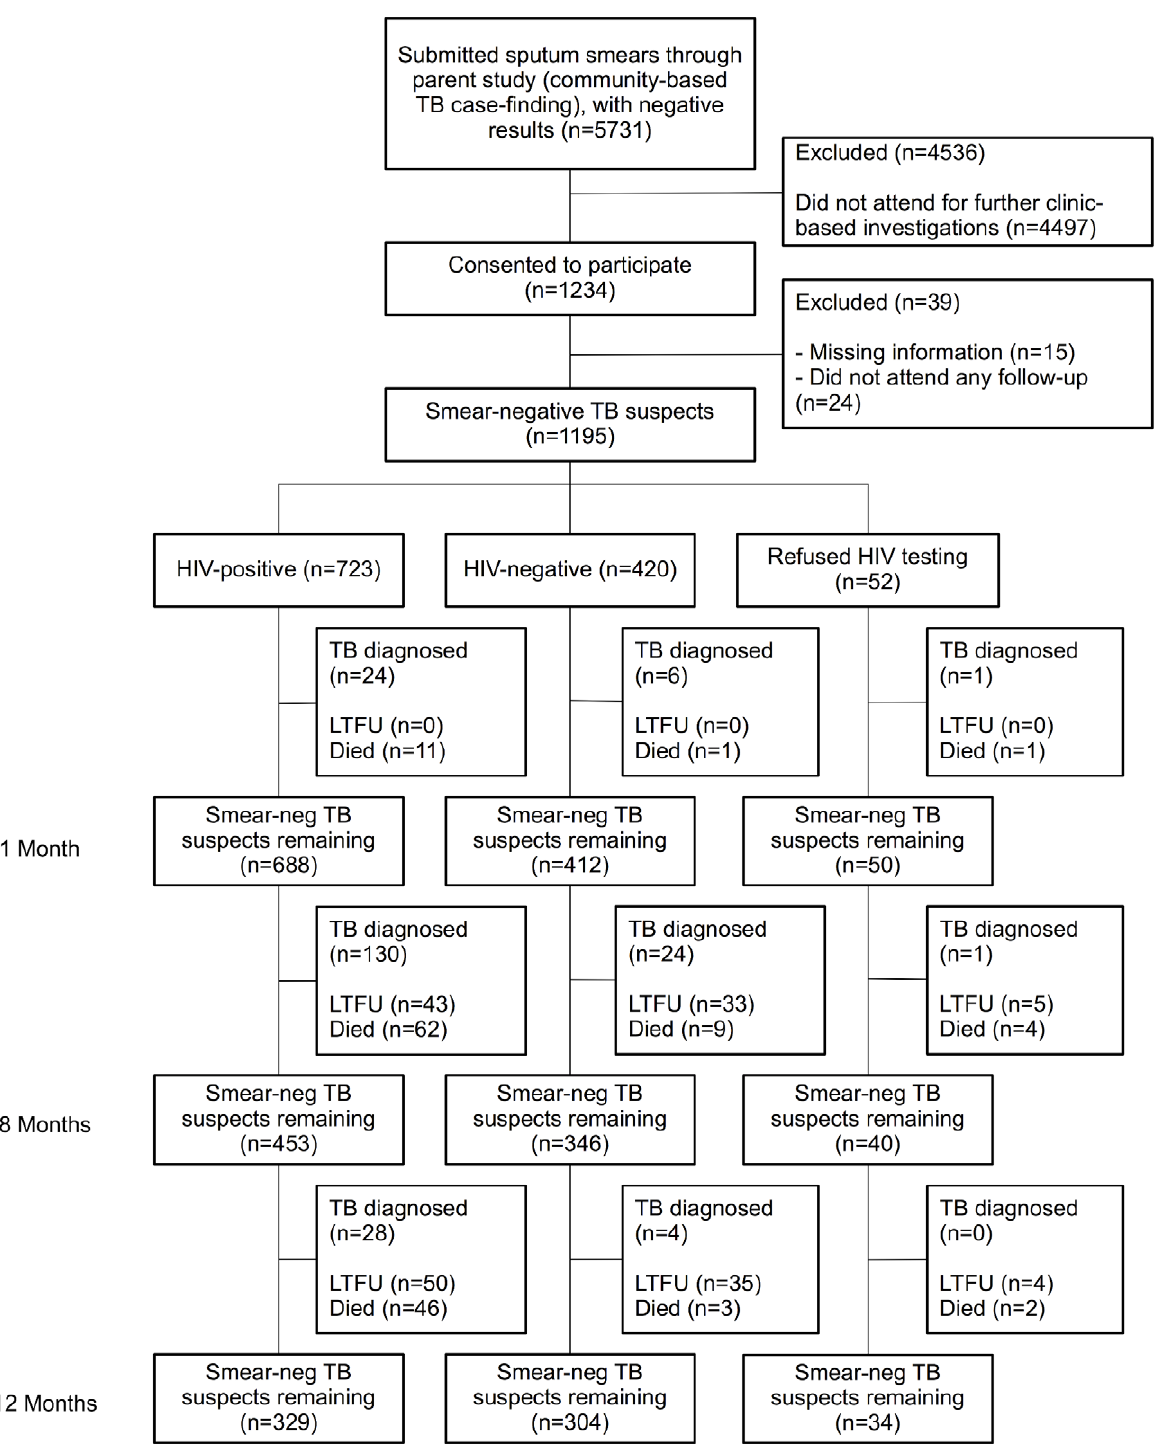
Figure 1. Cohort Flowchart. Diagnostic outcomes of smear negative TB suspects. LTFU: Lost to follow-up before TB diagnosis or in participant without TB diagnosed.